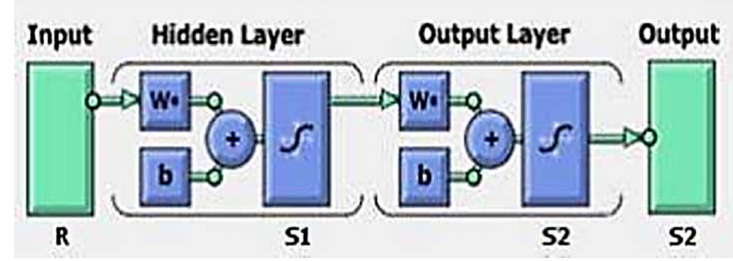
Figure 6. Neural network commonly used for